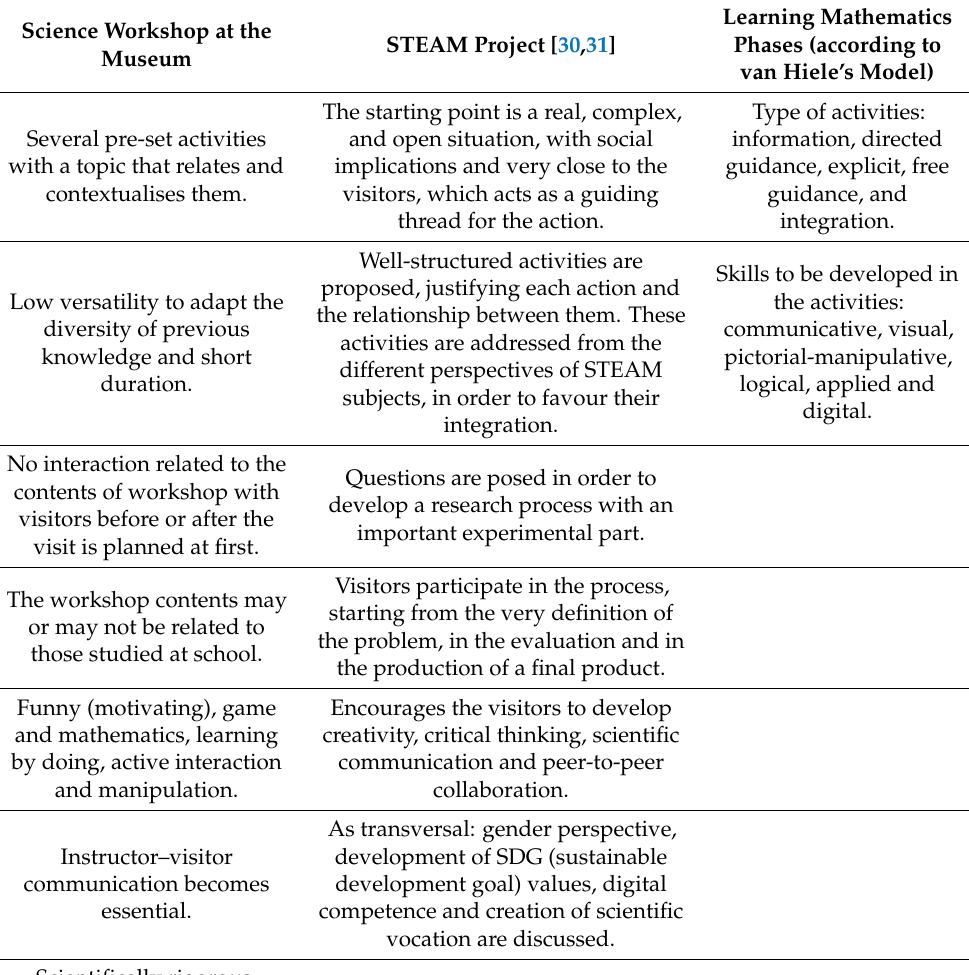
Table 1. Strengths of science workshop at museum, STEAM project and learning mathematics